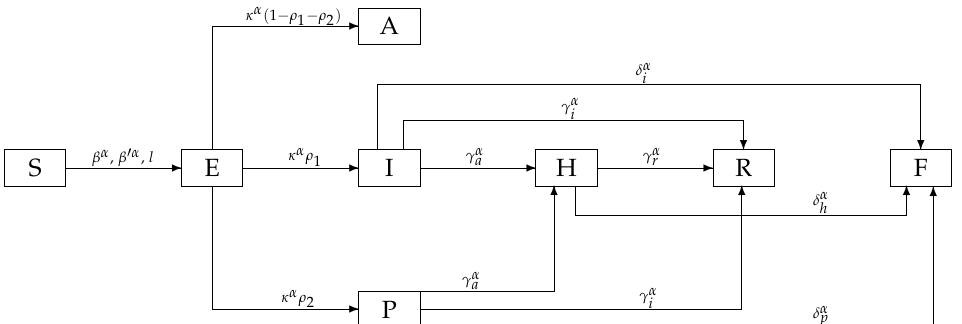
Figure 1. Flow diagram of the disease dynamics according to Model